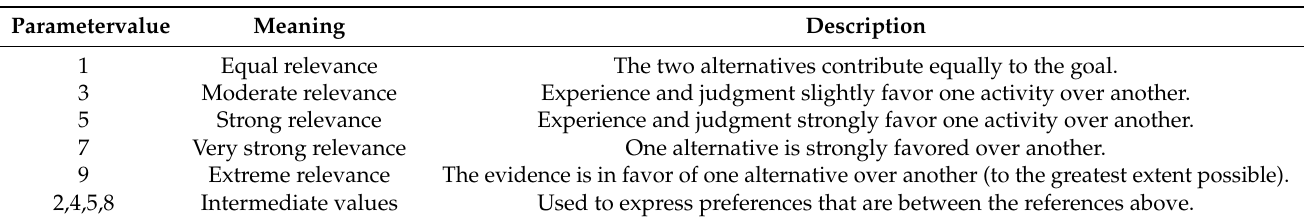
Table 3. Theoretical decision parameters of smart